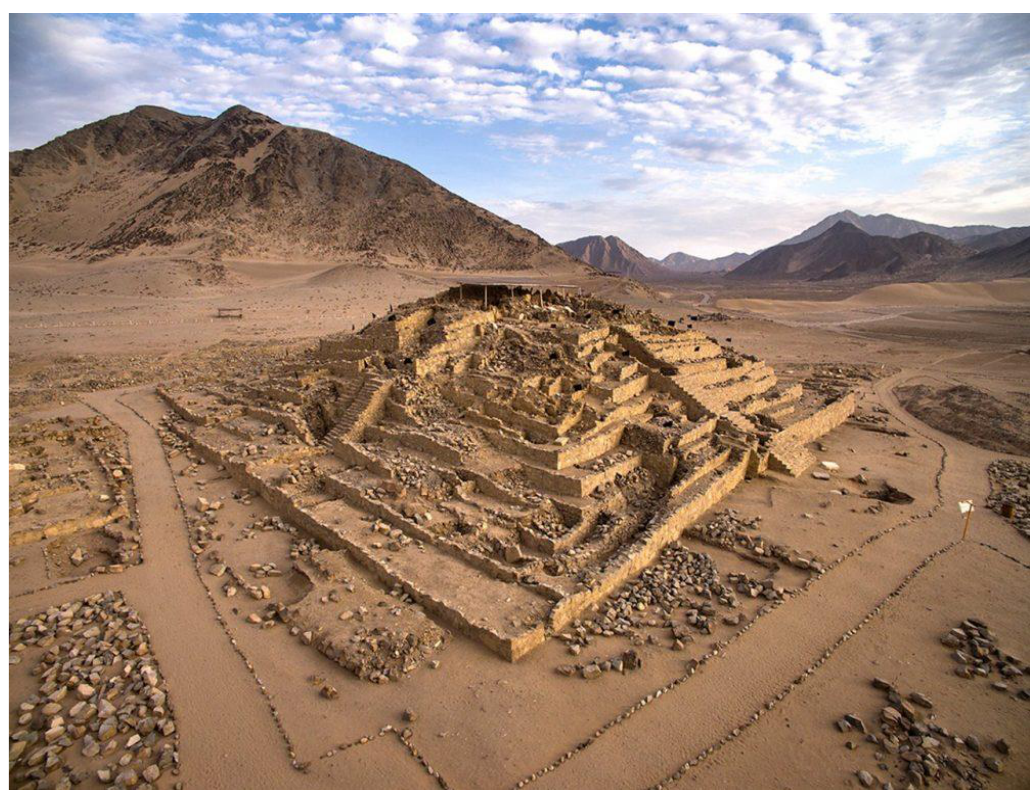
Figure 24. Details of the Major Pyramid; location indicated in Figure 23. Figure derived from [2], p. 226.